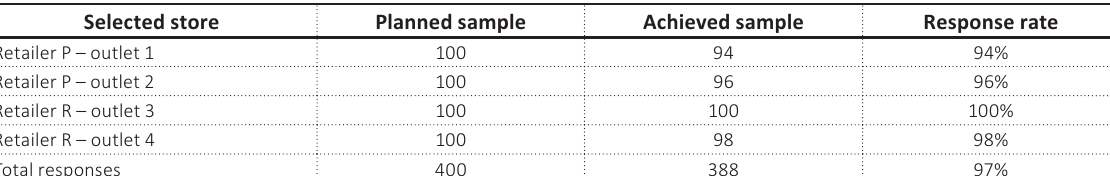
Table 3. Response rate results